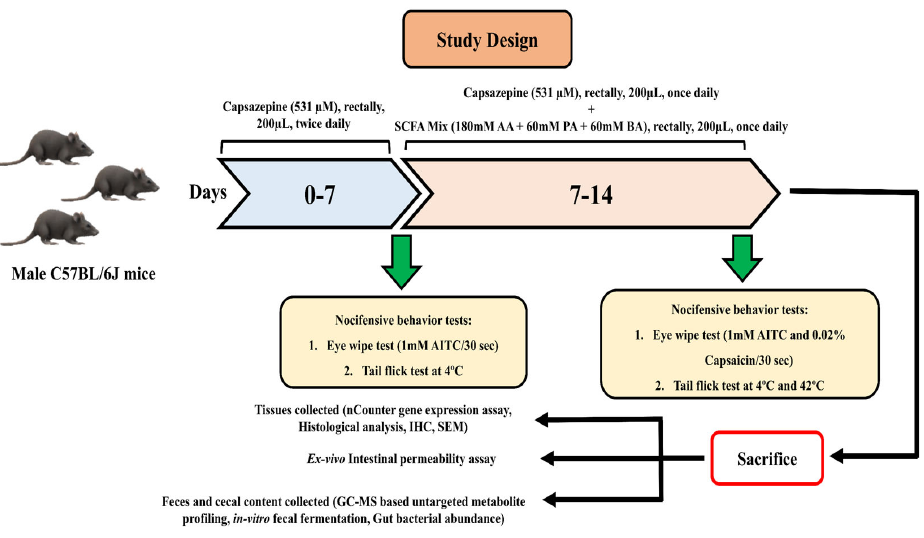
Figure 5. Animal experiment